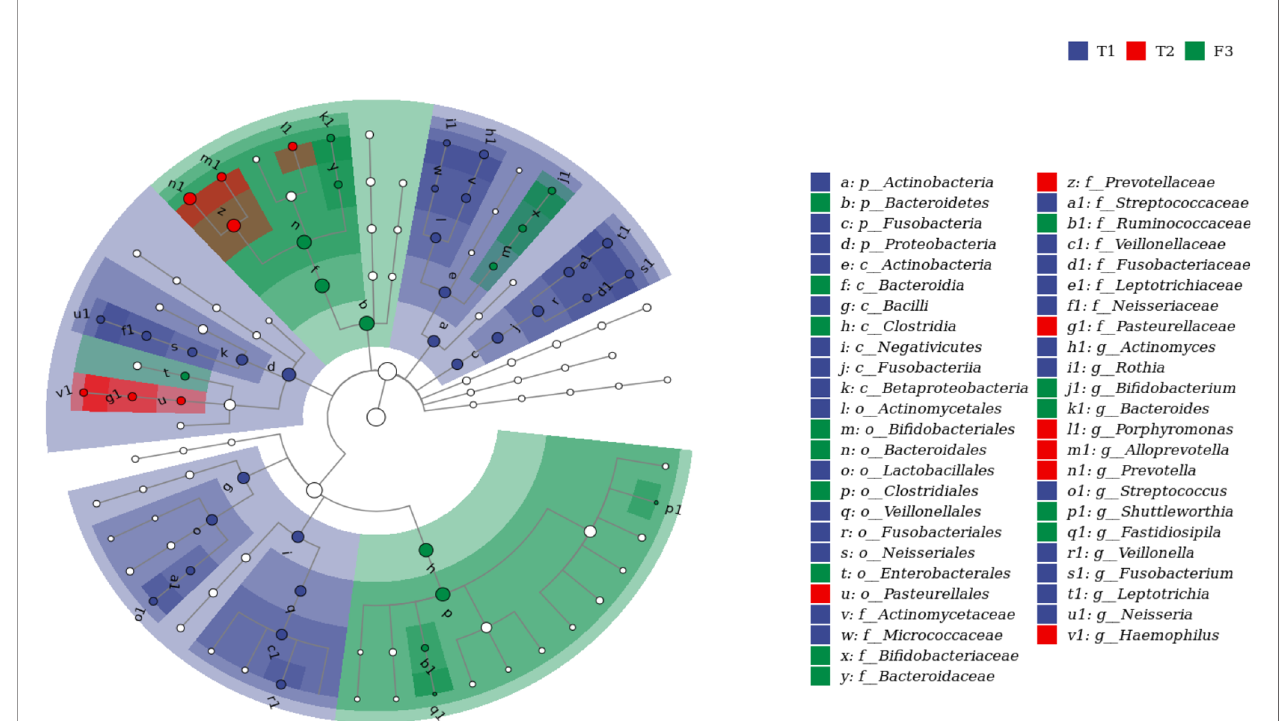
FIGURE 8 | The LEFSE analysis diagram of tongue coating and intestinal microbiota (the top 50 genera with LDA value, and the LDA threshold is 3.87. From the inner circle to the outer circle is the classi fi cation hierarchical relationship of the main taxa (from phylum to genera). The node size corresponds to the average relative abundance of the taxa; the hollow nodes represent taxa with insigni fi cant differences between groups, while nodes with other colors (such as green and red) indicate that these taxa exhibit signi fi cant differences between groups (p < 0.05), and the color represents a higher abundance in the grouping samples. The letters identify the names of taxa with signi fi cant differences between